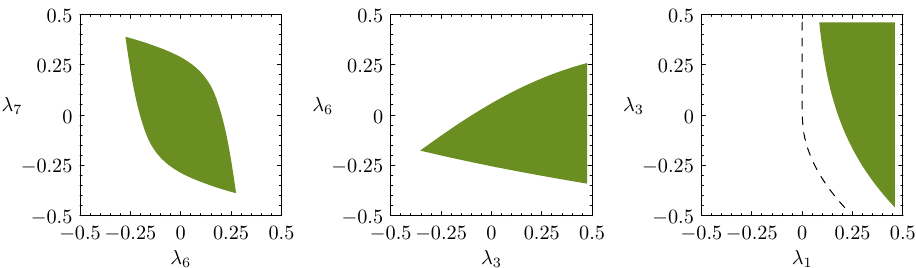
= 0 . 125, λ = 0 . 25 for the second panel , and λ λ 1 7 for the third panel (the dashed line shows the bound from copositivity for λ 6 = λ 7 =